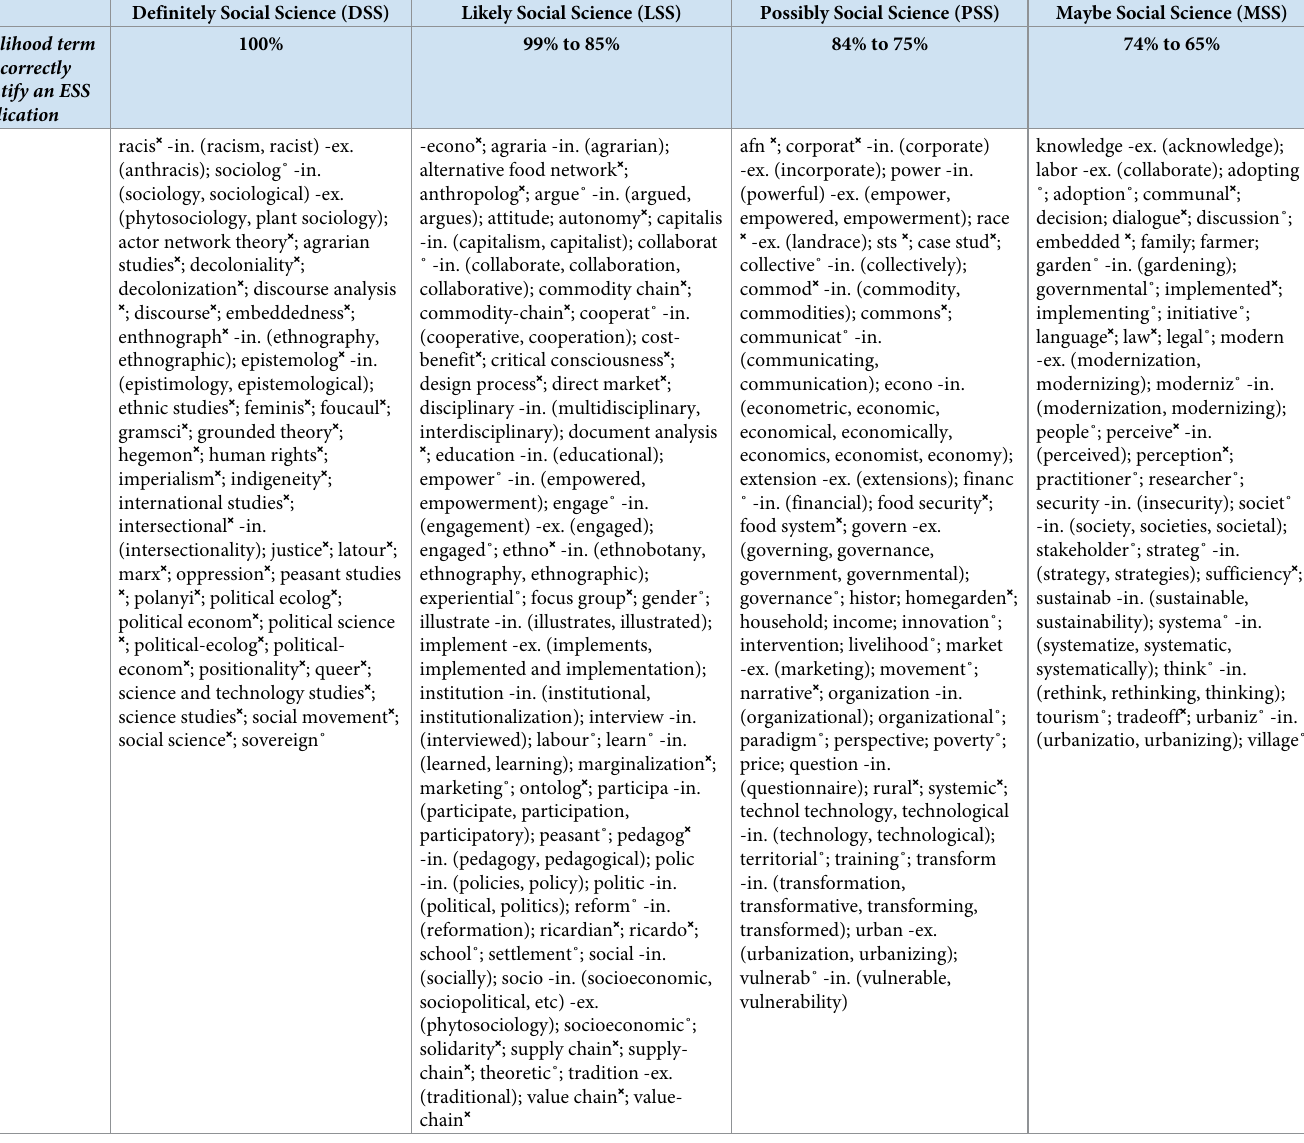
Table 2. 175 social science terms within the four term likelihood